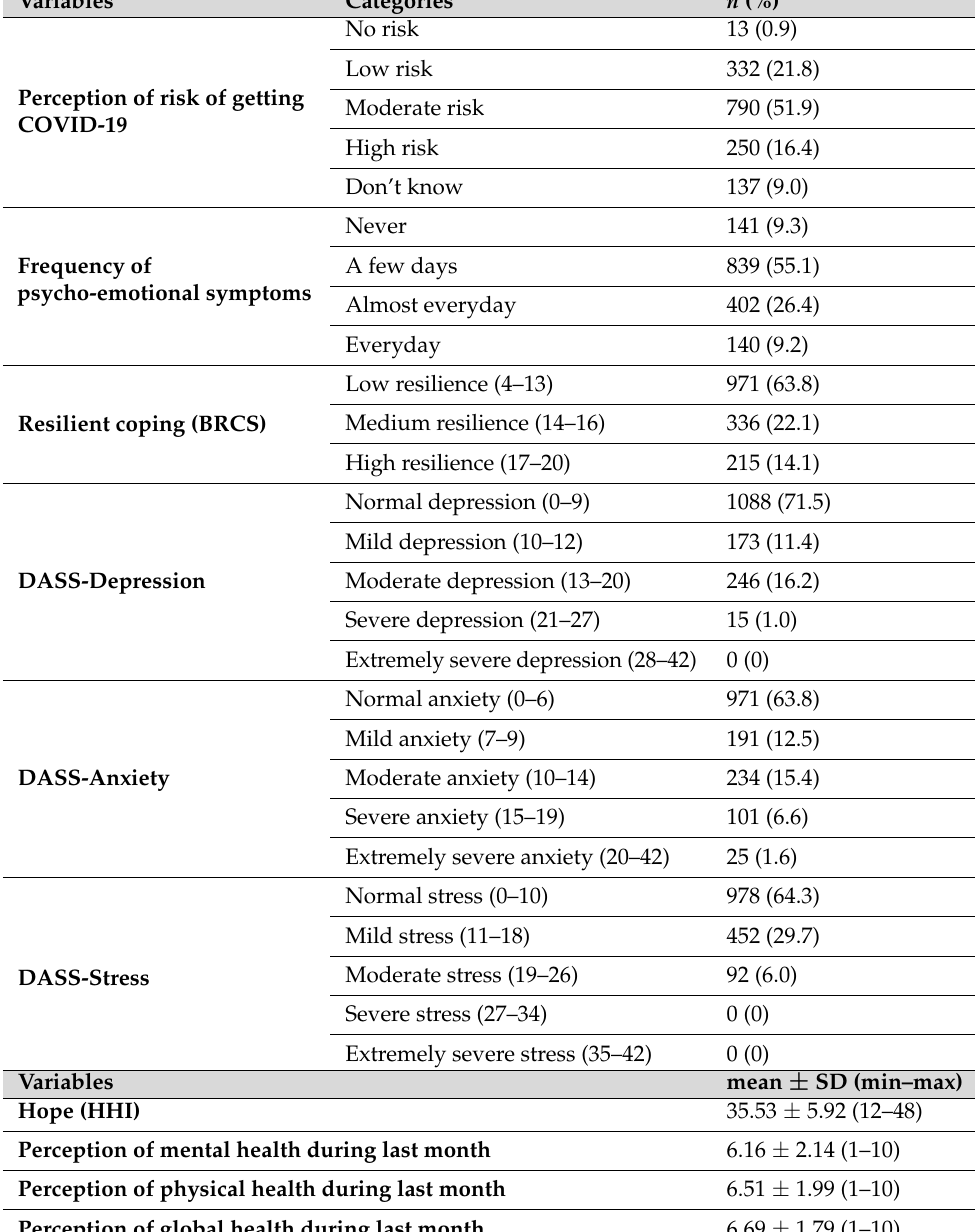
Table 2. Mental health status, psychological factors, and health-related perceptions of participants ( n =